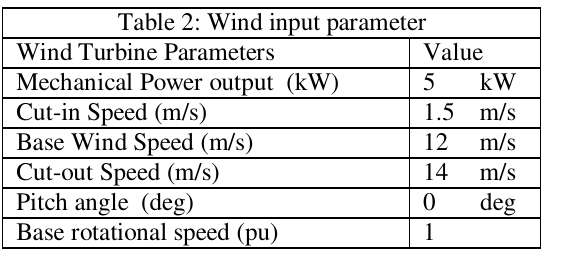
Table 3: Input parameter of Battery